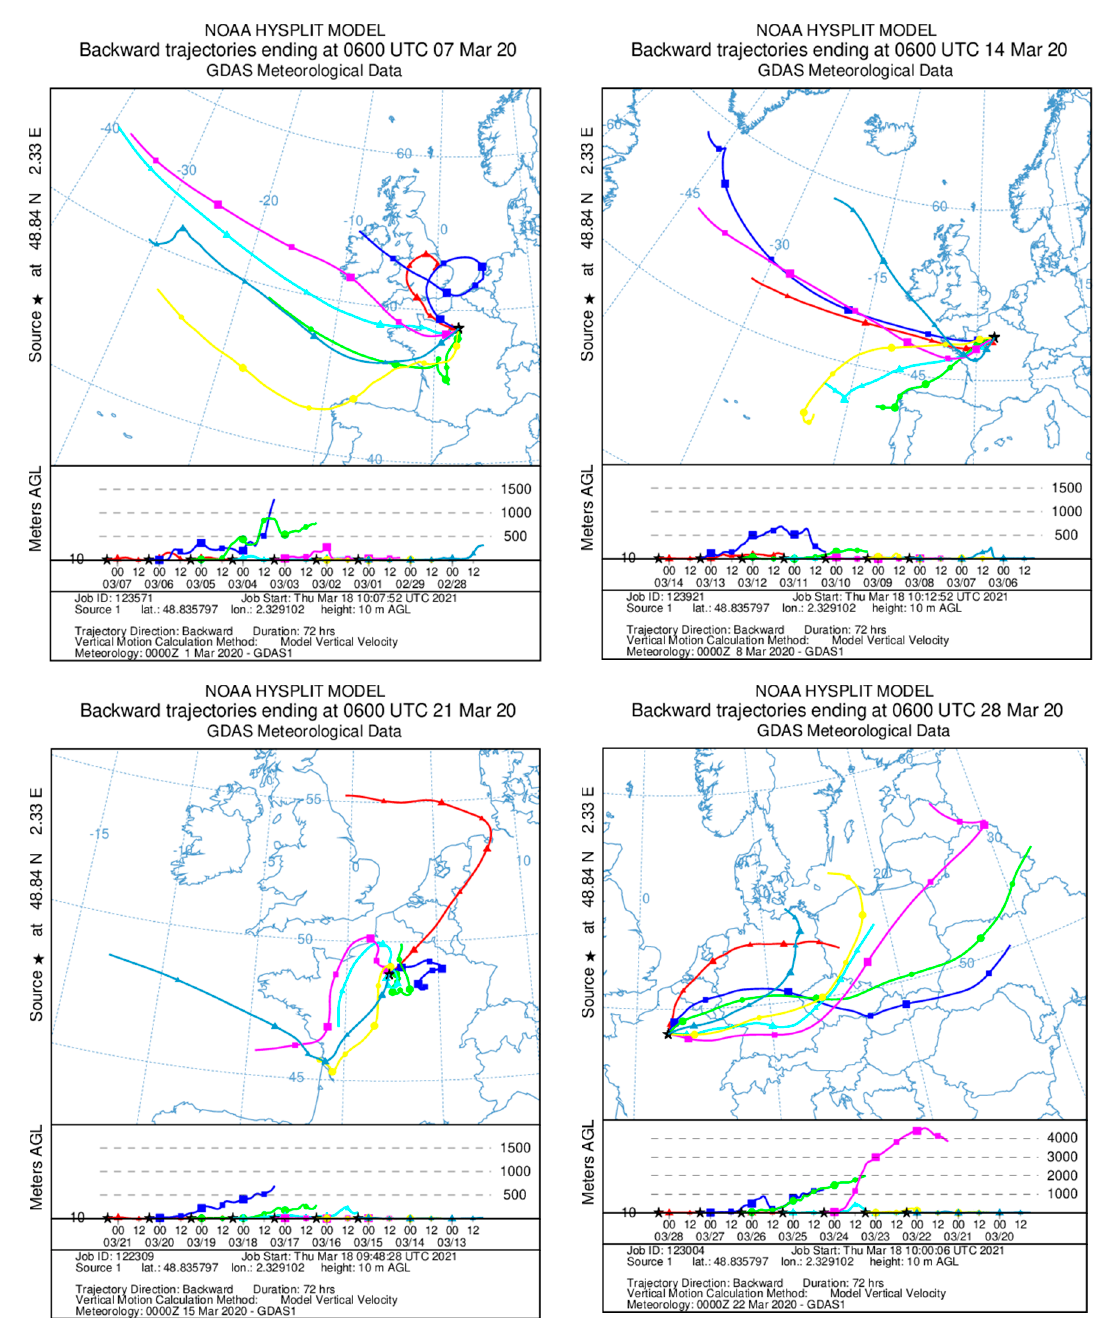
Figure 6. Calculated air mass back ‐ trajectories in Paris for March 2020.